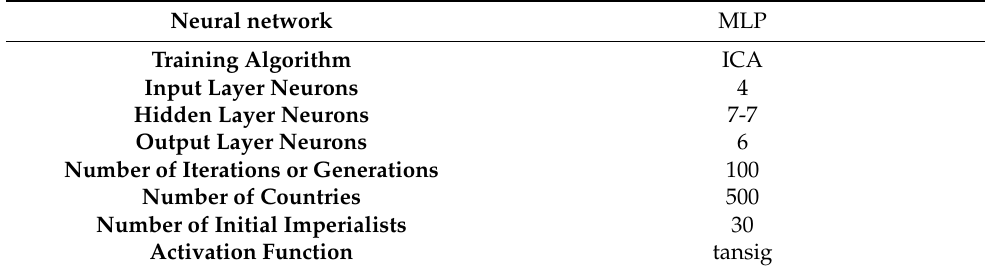
Table 1. The specifications of the ICA algorithm for initial modeling of the amplifier.